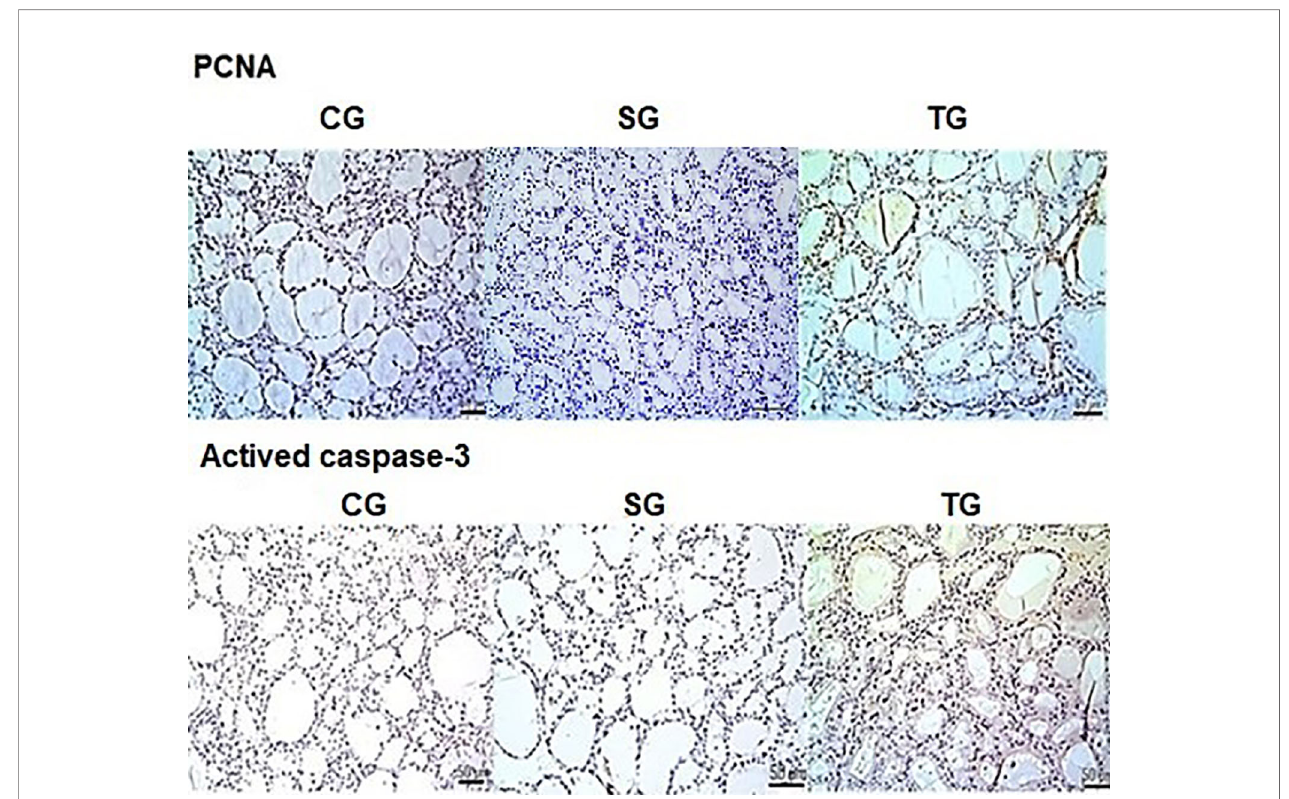
FIGURE 5 | There was a statistically signi fi cant increase ( p < 0.001) in the expression of PCNA in the TG compared to the CG (brown color marking). No differences were observed caspase-3 antibody immunoreactivity between both groups. Scale bars: 50